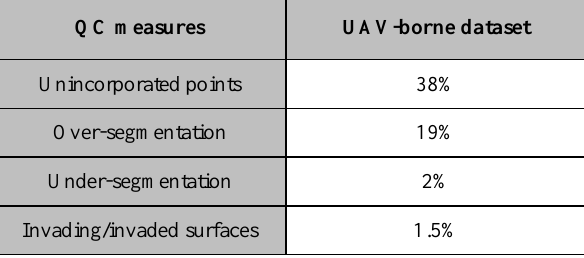
Table 1. Derived quality control measures for point cloud processing